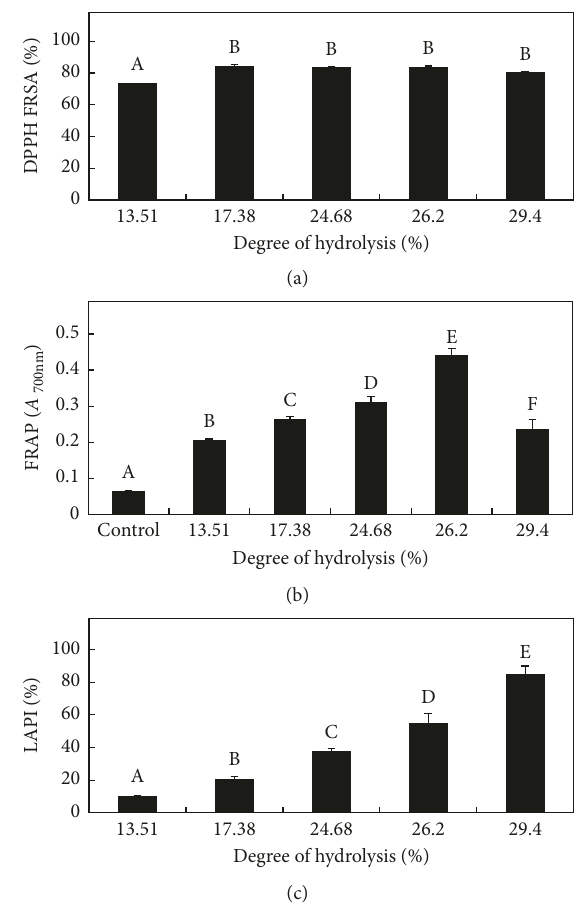
Supplementary Figure 1: SDS-PAGE profile of peptides released during hydrolysis of natural actomyosin (M- Marker; NAM-Natural Actomyosin; 0,10,20,30, 40, 50, 60- Time of hydrolysis; UL-Ultra low molecular weight markers): (A) natural actomyosin, (B) control sample during hydrolysis, (C) peptide pattern in 10% gel, and (D) peptide pattern in 15% gel. ( Supplementary Materials ) Figure 5: Antioxidant properties of cryptides obtained from natural actomyosin with different degrees of hydrolysis. Error bars represent the standard deviation from triplicate determinations. Different capital letters on the error bars indicate that the results are significantly different ( P 0 . 05). (a) DPPH free radical-scavenging activity at a peptide concentration of 1 mg/ml (DPPH FRSA); (b) ferric-reducing antioxidant power (FRAP) at a peptide con- < centration of 1mg/ml; (c) linoleic acid peroxidation inhibition activity (LAPI) at a peptide concentration of